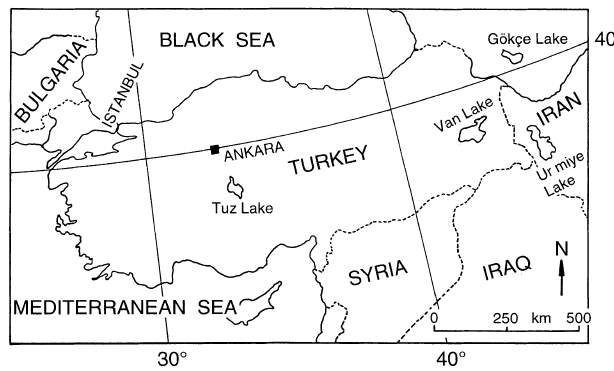
Fig. 1. Location map